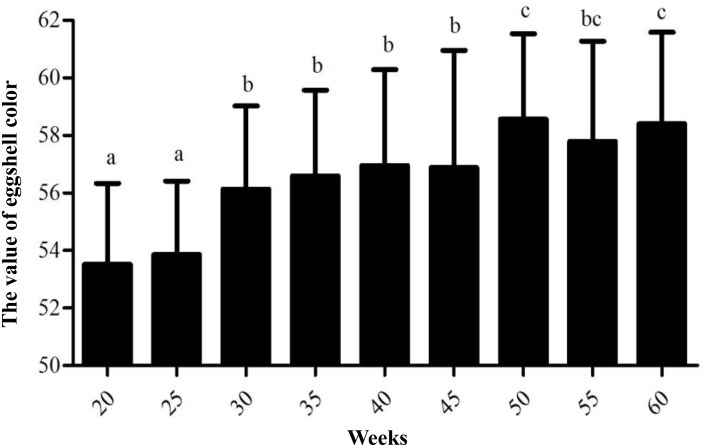
The value of eggshell color at different weeks. Different lowercase letters indicate P < 0.05, and the same letters indicate no difference (P > 0.05); the larger the eggshell color value is, the lighter the eggshell color of the egg.